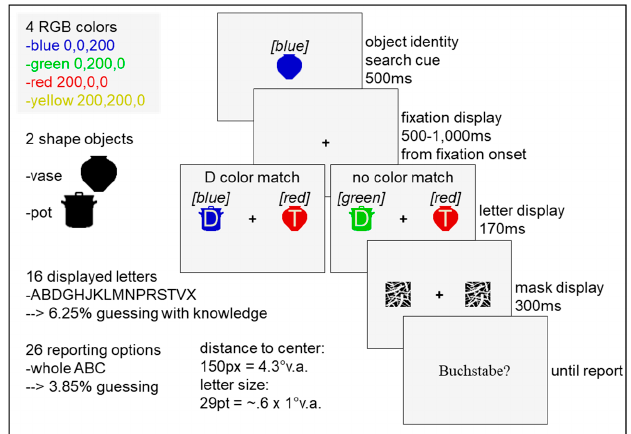
Figure 3. Material, procedure, and design of Experiment 2. Either only the distractor (D color match) or no object (no color match) of the letter display matched the cue in its irrelevant color. The color words in brackets are added for greyscale printing. Neither the color words, nor the condition names were present during the experiment. “Buchstabe” is the German word for letter. The schematic drawing is not true to